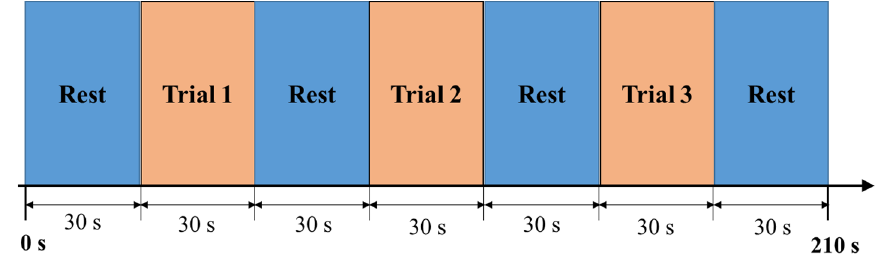
Figure 2. The procedure outline for each task.